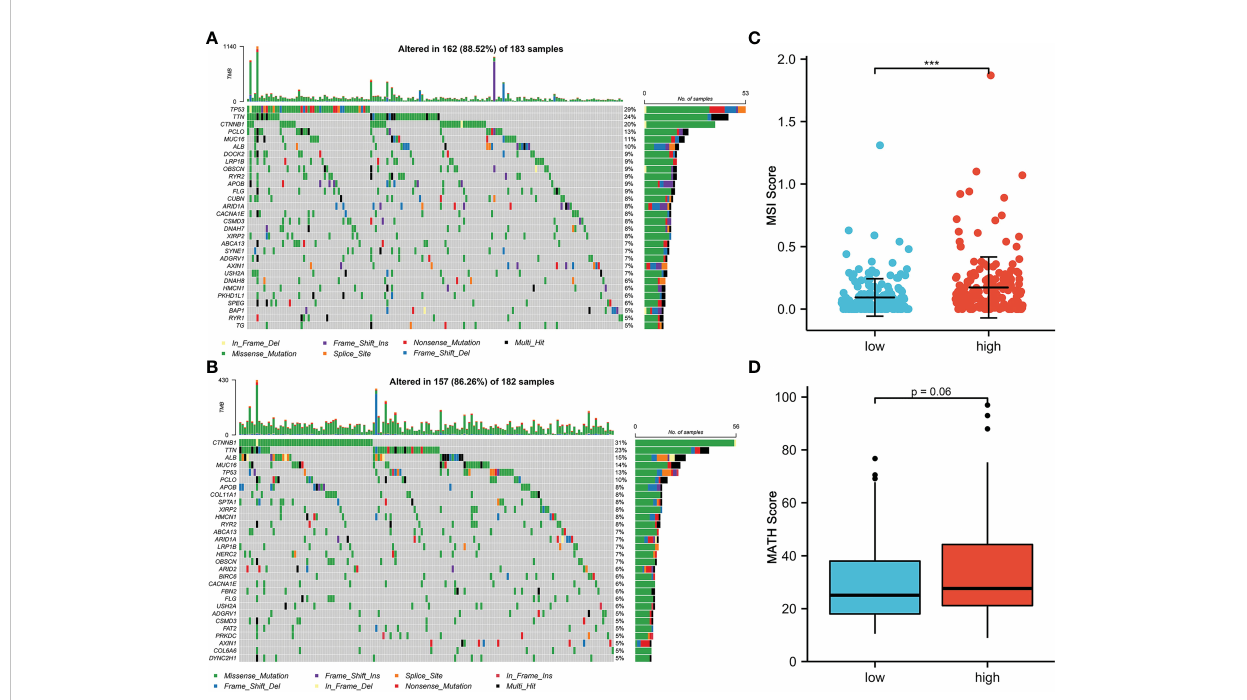
FIGURE 4 CRFCS and mutation characteristics. (A, B) Mutation oncoplots of high CRFCS group (A) and low CRFCS group (B) , including genes with top 30 mutation frequency. (C) Differences in MSI scores between high and low CRFCS subgroups. *** stands for p<0.001. (D) Differences in MATH scores between CRFCS